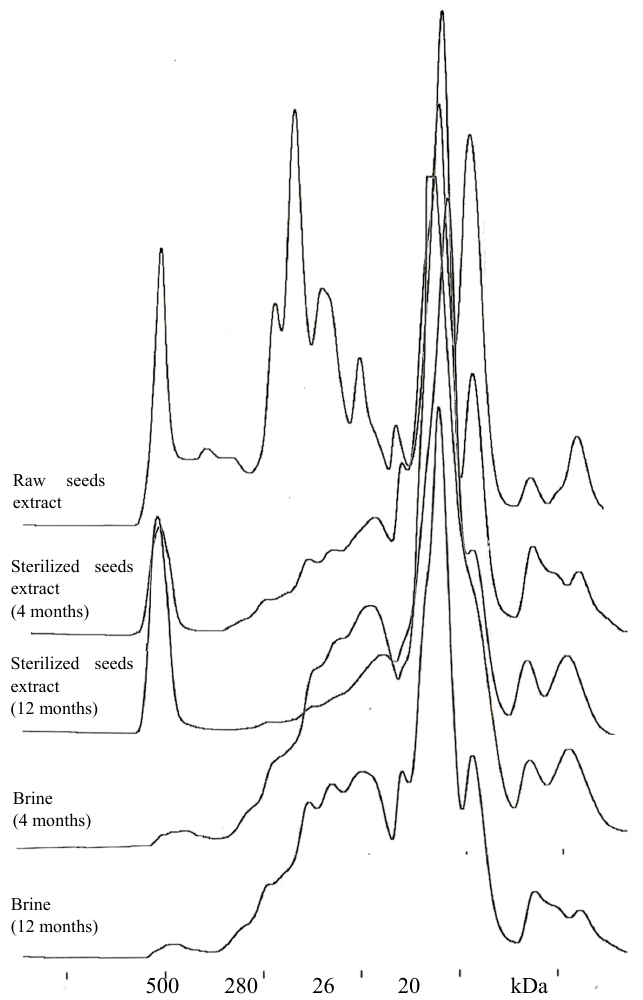
Figure 1. Gel filtration chromatograms of protein fractions in water extracts from white bean seeds before and after processing and in the brine.